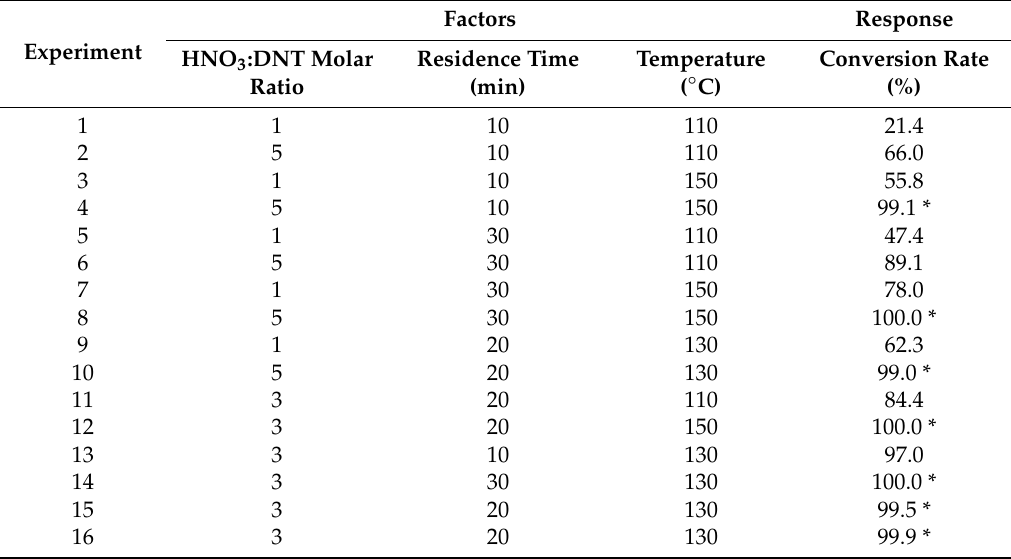
Table 1. Reaction conditions and obtained conversion rates of the experiments performed according to the design of experiments (DoE) approach.